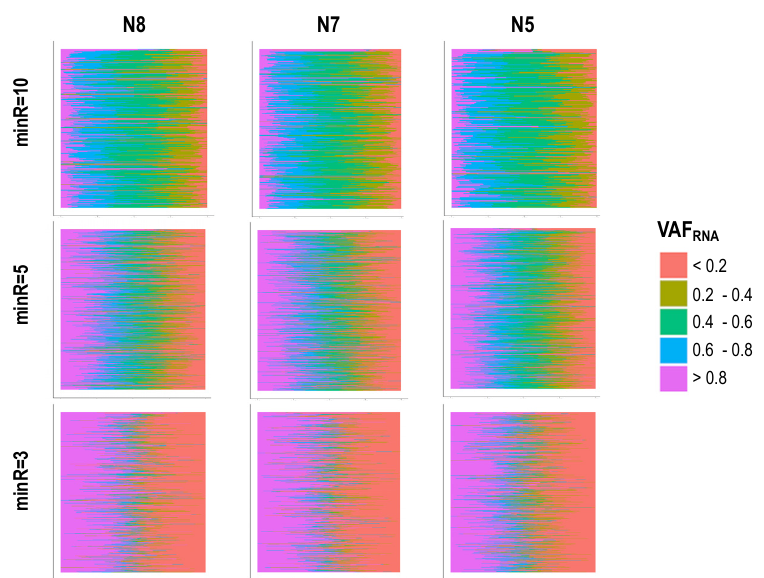
Figure 5. scVAF RNA estimated at positions covered by a minimum of 10 sequencing reads (top), 5 sequencing reads (middle), and 3 sequencing reads (bottom), across more than 1000 cells. For the majority of positions, VAF RNA showed bi-allelic expression, with a substantial proportion of the scVAF RNA estimations in the interval 0.4–0.6.